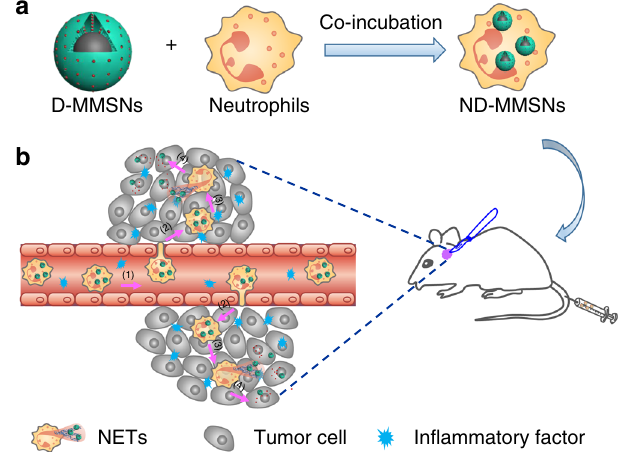
Fig. 1 Fabrication and targeted-therapeutic schematics of ND-MMSNs. a Schematic illustration of the preparation of ND-MMSNs. b Schematic shows that in fl ammation-activatable ND-MMSNs target in fl amed glioma sites and phagocytized D-MMSNs would be released to achieve residual tumor